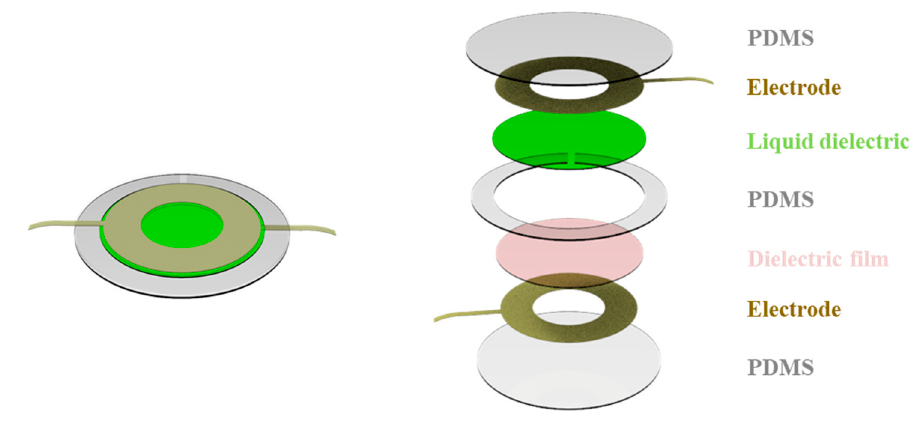
Figure 1. The composition of the electro-hydraulic haptic feedback